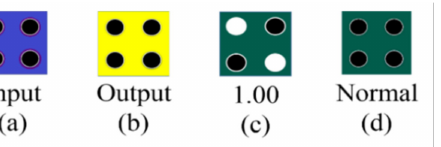
Figure 8. Cells in QCADesigner: ( a ) input cell, ( b ) output cell, ( c ) fixed and ( d ) normal [38].